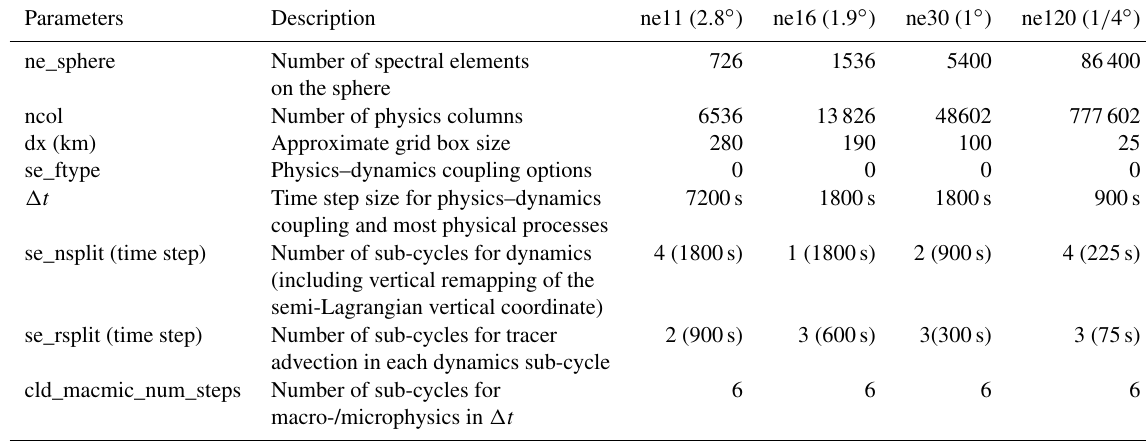
Table 4. Default model configuration parameters for EAM V1 α at various spatial resolutions. All configurations use a radiation time step of 1h.